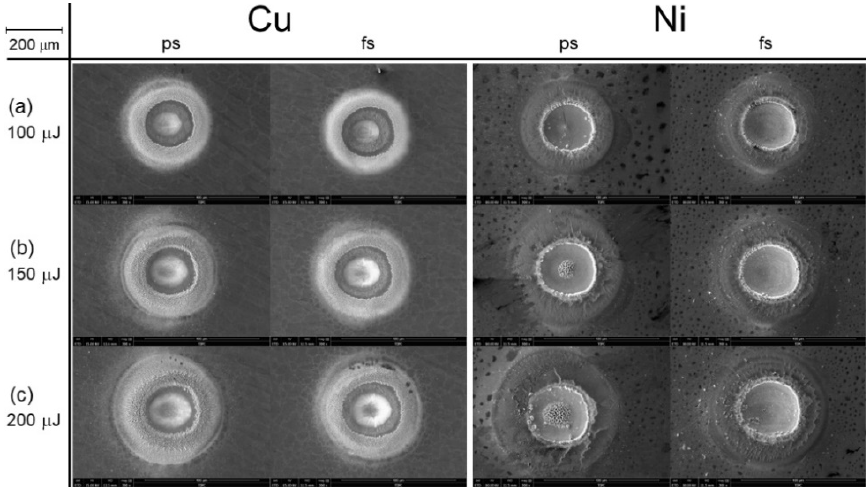
Figure 4. Surface ablation morphologies obtained by SEM for Ni and Cu specimens under different pulse widths and same number of pulses (1000) for: ( a ) 100 μ J; ( b ) 150 μ J; ( c ) 200 μ J.